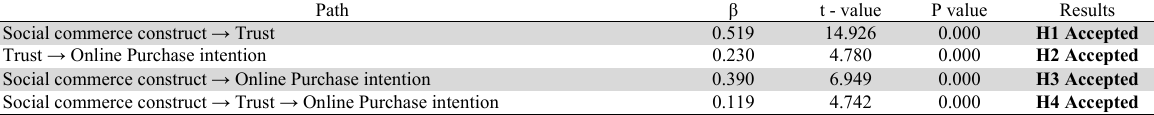
The results of path